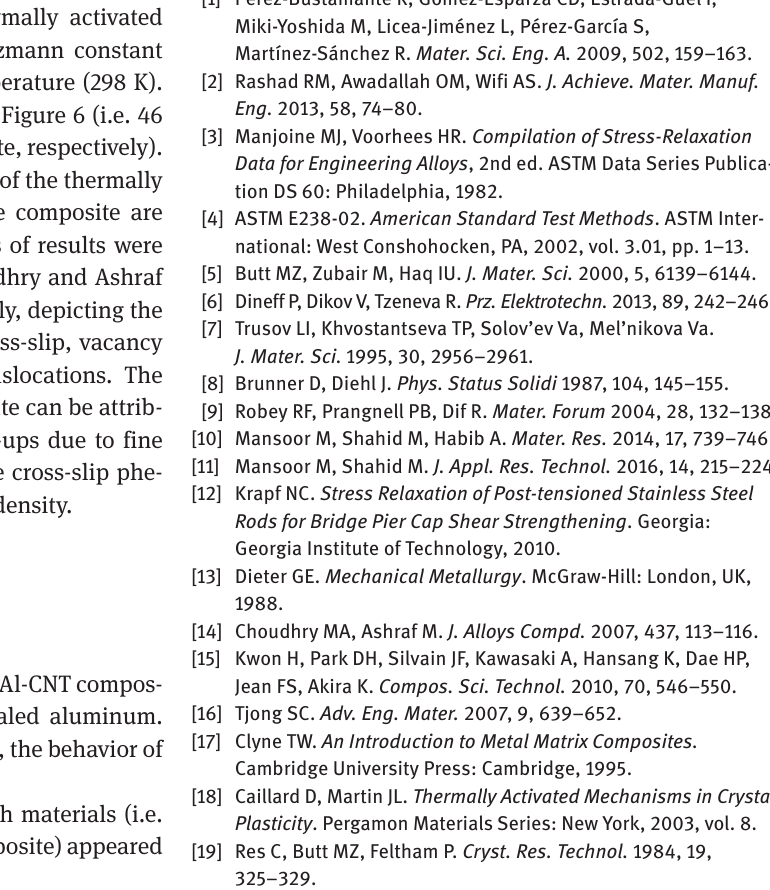
The stress relaxation, hardening component, and intrinsic height of thermally activated barriers were significantly influenced by the presence of nanotubes in the aluminum matrix. 4. The stress relaxation rate of the composite was > 30% less than that of aluminum, whereas the hardening component of the composite was twice more than that of aluminum. At low strains, the hardening com- ponent dominated stress relaxation. 5. The calculated strengths of the thermally activated barrier ( U ) for aluminum and the composite were 1.7 o and 2.6 eV, respectively, which are of the order of mag- nitude for recovery processes. The U of the composite o was comparable with that of the AA7075 alloy in the annealed condition.